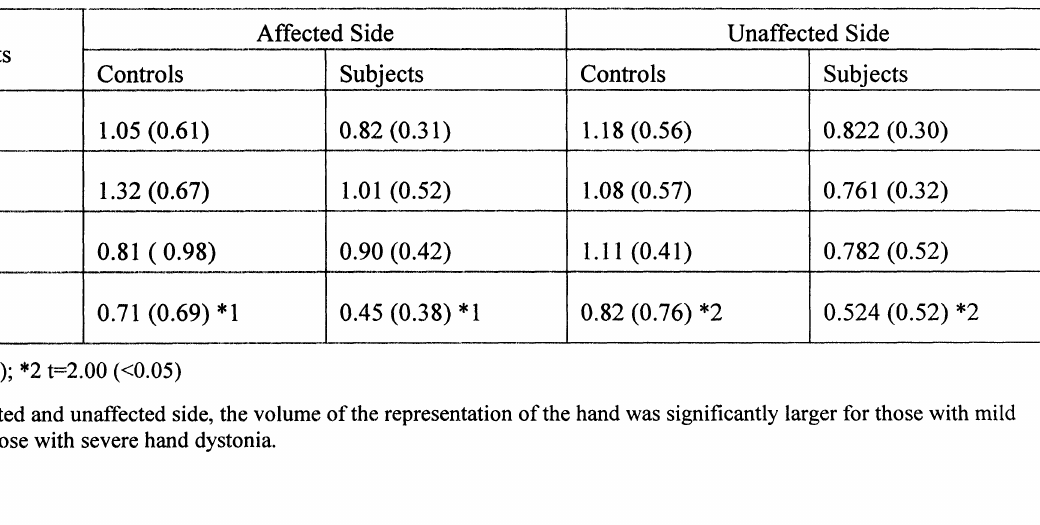
Somatosensory evoked field response by severity of dystonia: digit spread by axes and volume Spread of